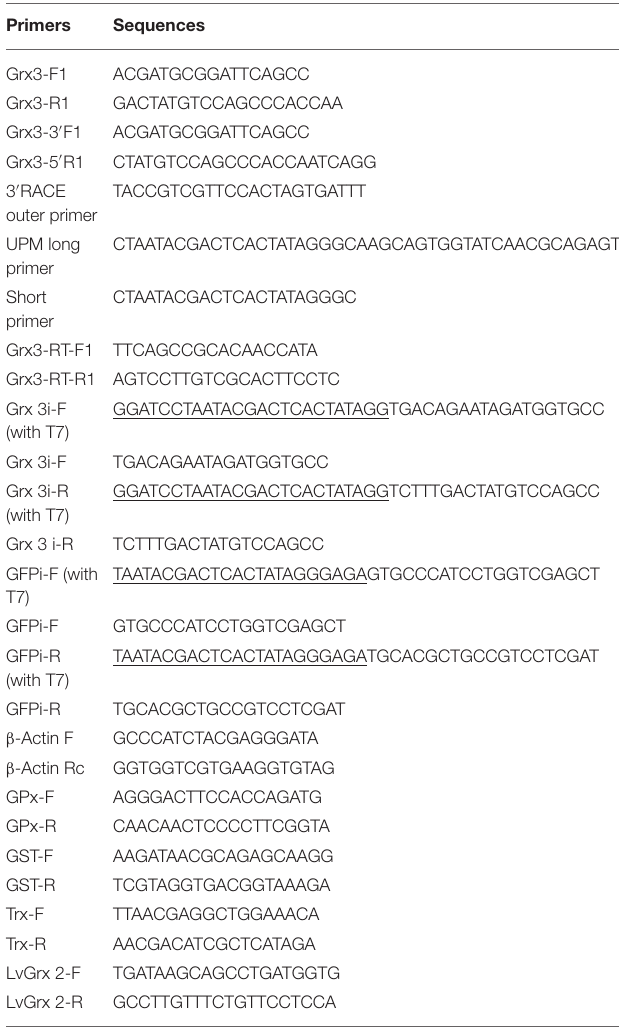
TABLE 1 | Summary of primers used in this